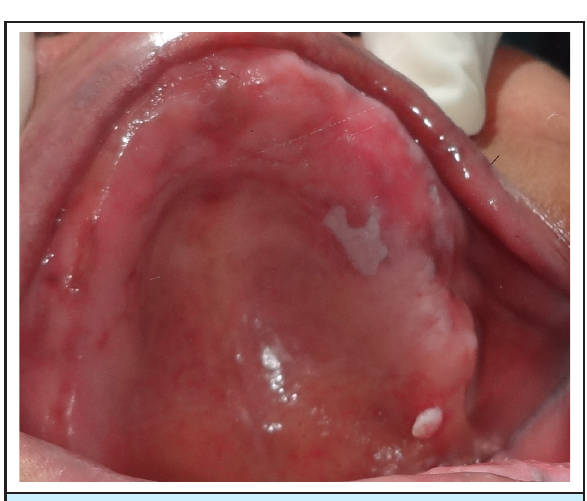
Figure 1. Clinical photograph showing the lesion.